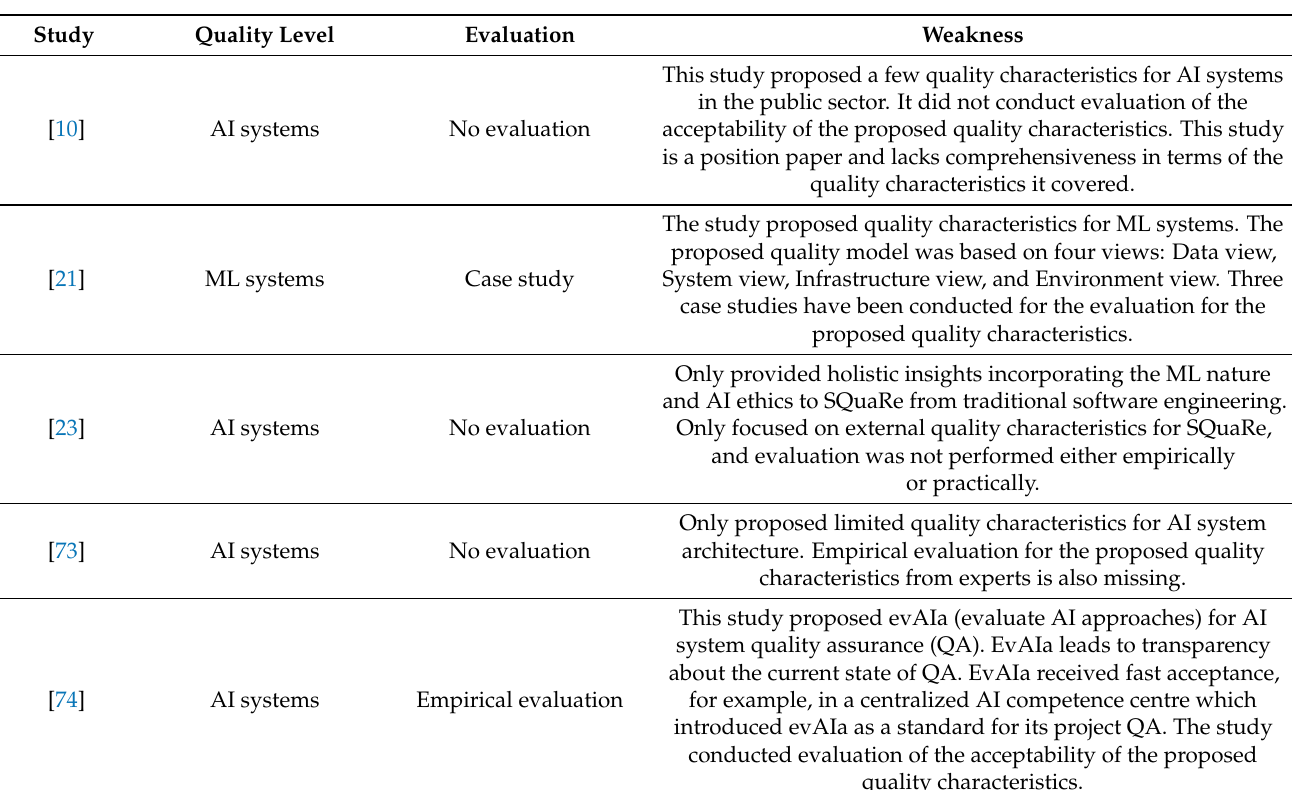
Table 7. Existing Quality Models for AI Systems.